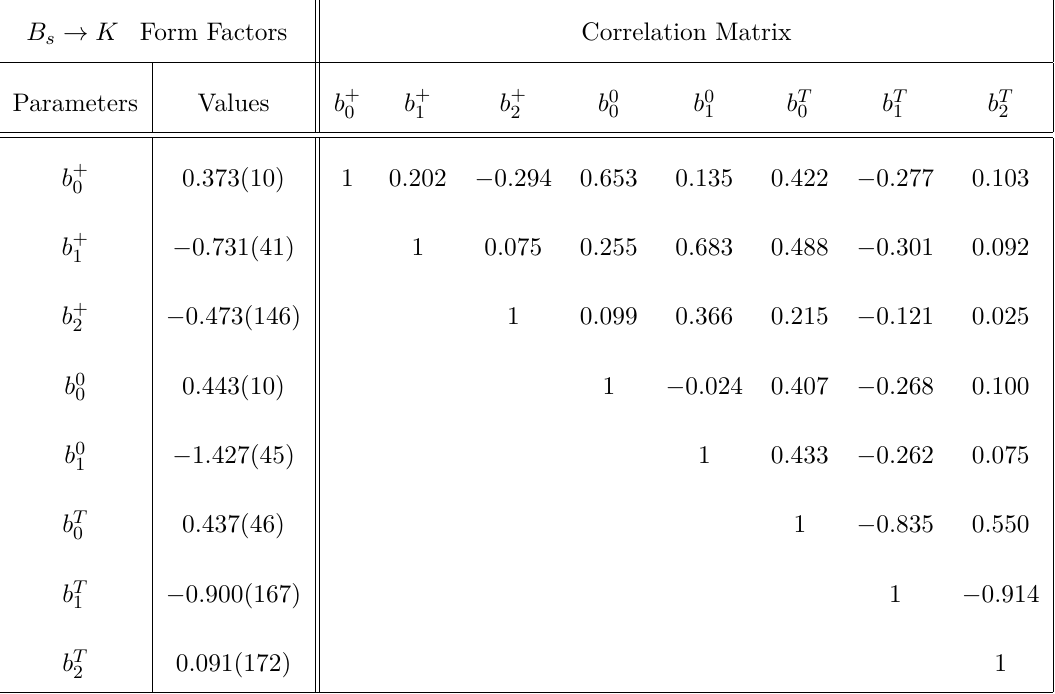
Table 4 . Theory predictions for the correlated z -series coefficients in the vector, scalar and tensor B s → K form factors determined by fitting the BGL parametrization simultaneously against our LCSR results including a variety of the subleading-power corrections and the available lattice QCD data points from [4, 8, 11] with the preferred truncation N = 3